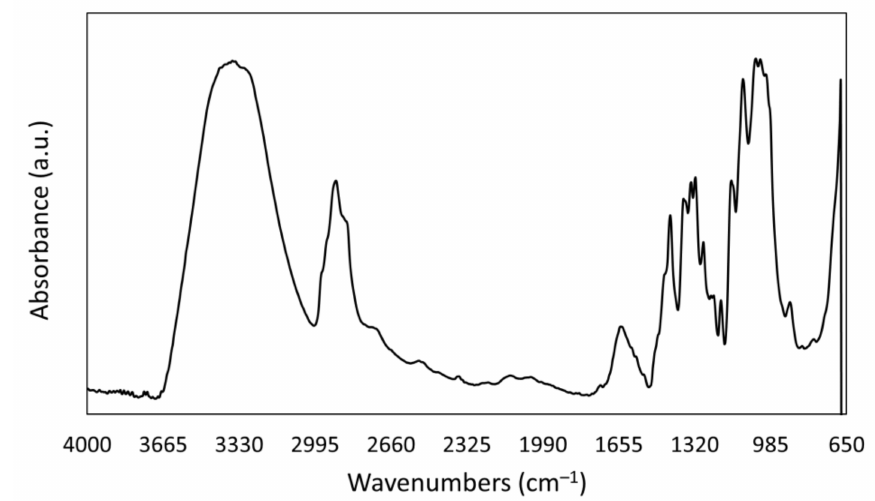
Figure 3. FTIR spectrum of textile fibers.